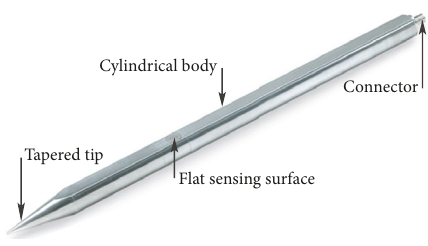
Figure 10: Pencil probe.